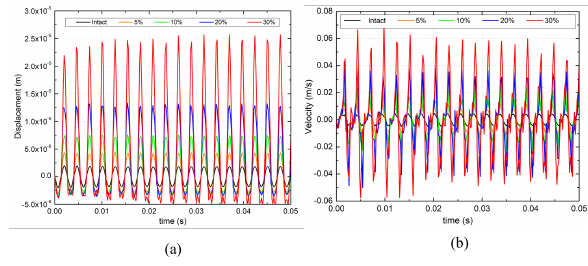
Figure 8: Dynamic response of frequency ratio η =1/3 between intact and debonded models a) displacement b) velocity.